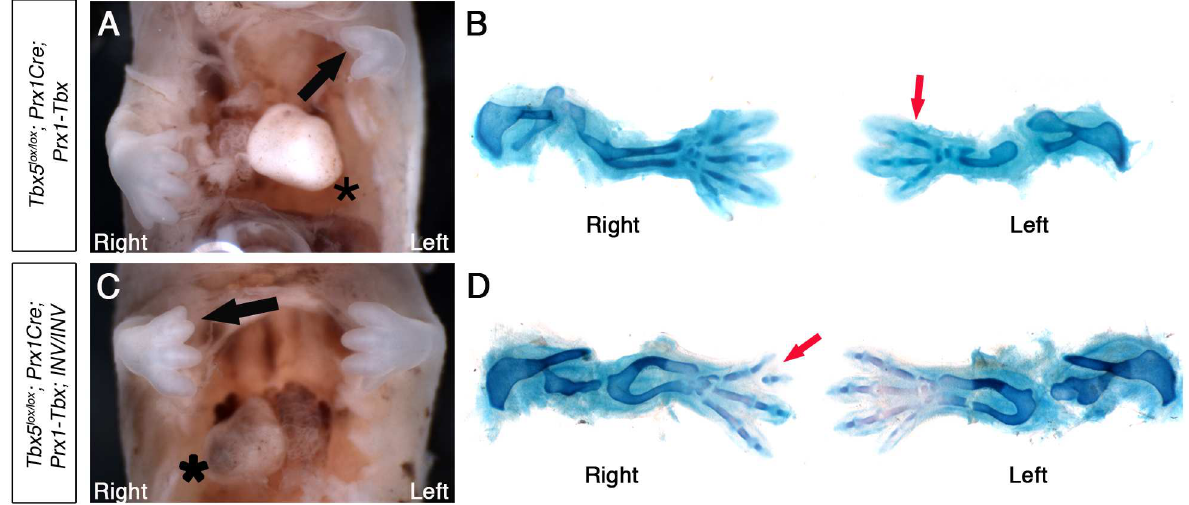
Fig 5. Tbx5 lox/lox ;Prx1Cre;Prx1-Tbx;INV/INV mutants with situs inversus have right biased asymmetric forelimb defects. A, Tbx5 lox/lox ;Prx1Cre;Prx-Tbx mutant embryo at E14.5. The heart is on left (asterisk). B, Skeletalpreparation. Right forelimbhas 4 digits, whileleft forelimb has 3 digits (red arrow). C, Tbx5 lox/lox ;Prx1Cre;Prx1-Tbx;INV/INV mutant embryo at E14.5. The heart is on the right (asterisk), indicating situs inversus .The right forelimb is more severely affected than the left (black arrow). D, Skeletal preparation. The left forelimbhas 4 digits. In contrast, the right forelimb is more severely affected having 3 digits with the most anterior bifurcated (red arrow).